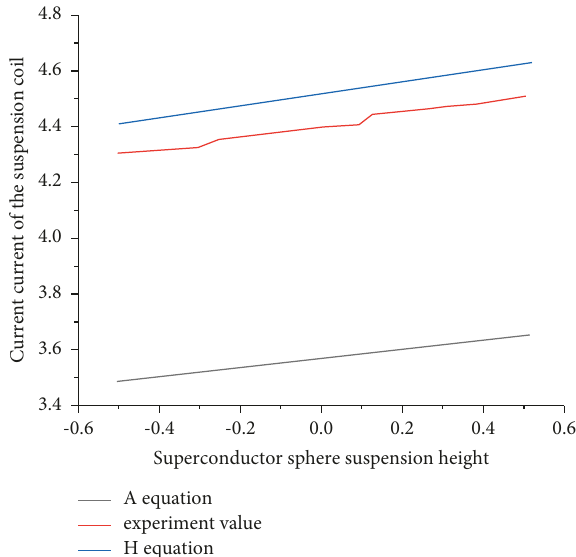
Figure 1: The relationship between the levitation height and coil